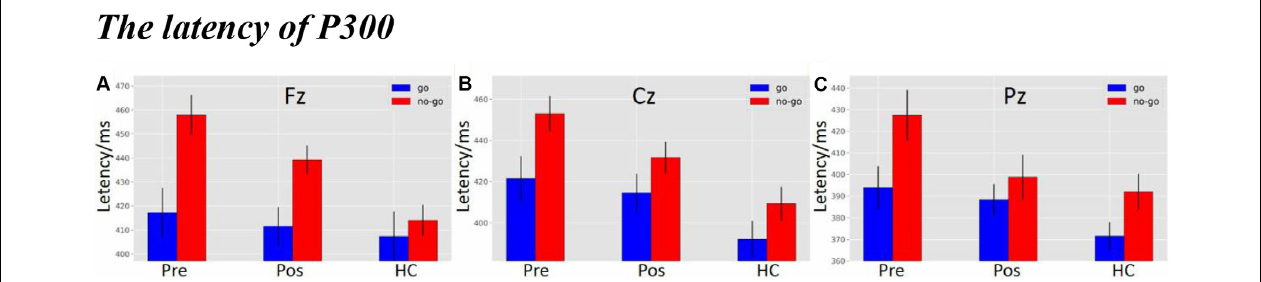
FIGURE 5 | (A) The P300 latency among three groups under three different types of stimuli at Fz electrode. (B) The P300 latency among three groups under three different types of stimuli at Cz electrode. (C) The P300 latency among three groups under three different types of stimuli at Pz electrode (the time window of P300; pre, pre-operative group; post, post-operative group; HC, healthy control